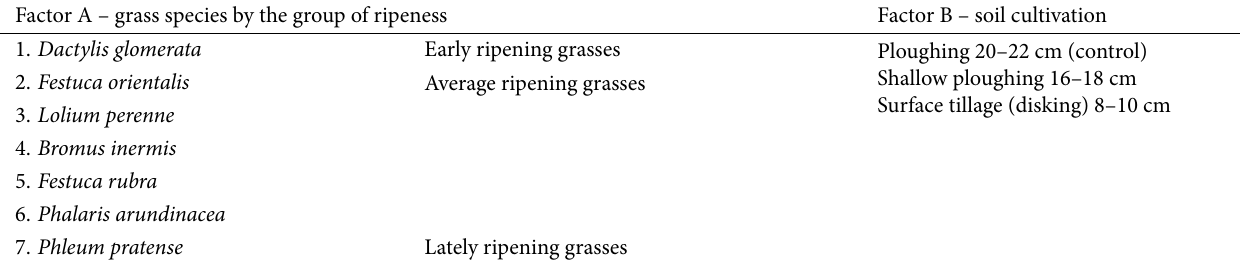
Table 1 Experimental. Factor A – grass species by the group of ripeness Factor B – soil